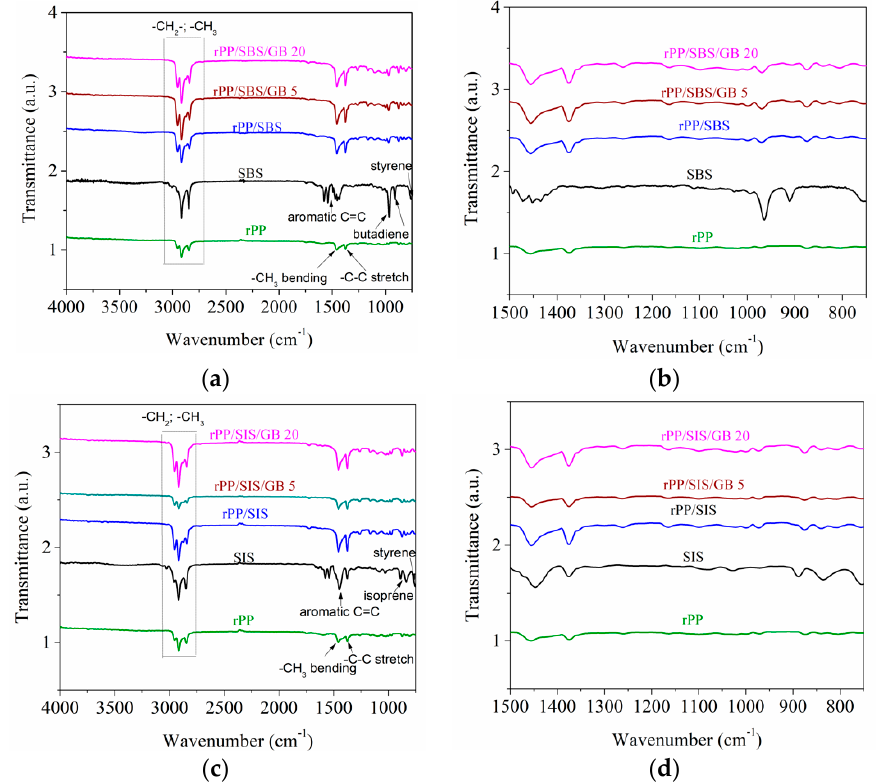
Figure 4. Normalized Fourier Transform Infrared Spectroscopy in Attenuated Total Reflectance mode (ATR-FT-IR) spectra for ( a ) rPP/SBS/GB composites in the spectral range 4000–750 cm − 1 , ( b ) rPP/SBS composites in the spectral range 1500–750 cm − 1 , ( c ) rPP/SIS/GB composites in the spectral range 4000–750 cm − 1 , and ( d ) rPP/SIS/GB composites in the spectral range 1500–750 cm − 1.